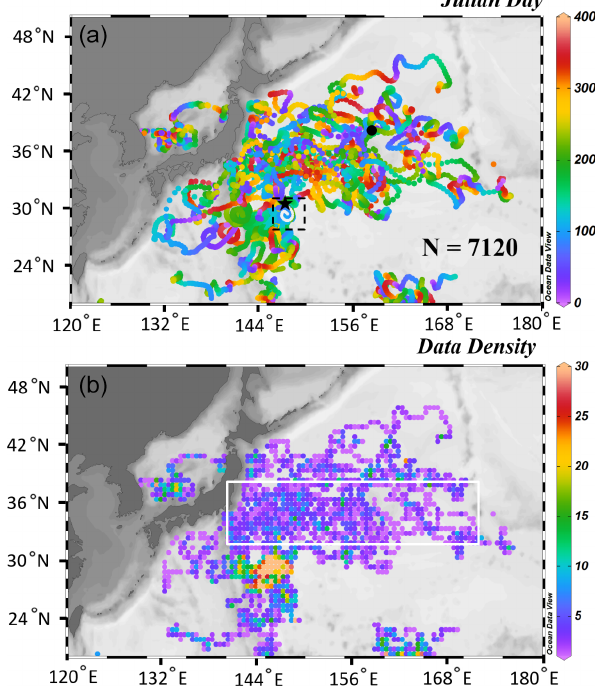
Figure 2. Horizontal distribution of the quality-controlled BGC- Argo data profiles between 2008 and 2019 in the western North Pacific. The Argo profiling tracks are color-coded by the Julian day (a) and data density (number of available profiles) for each grid (0 . 5 ◦ × 0 . 5 ◦ ) (b) . The location of Station no. 234 from float MD5904034 is denoted by the black dot in (a) (see Fig. 3); the white curve inside the dashed box represents the trajectory of float MR2901556 between 28 July and 18 August 2014, and the black star indicates the beginning of the float trajectory during this period (see Fig. 4). The white box in (b) denotes the region with strong energetic ocean processes (i.e., Kuroshio–Oyashio Extension, asso- ciated with eddy